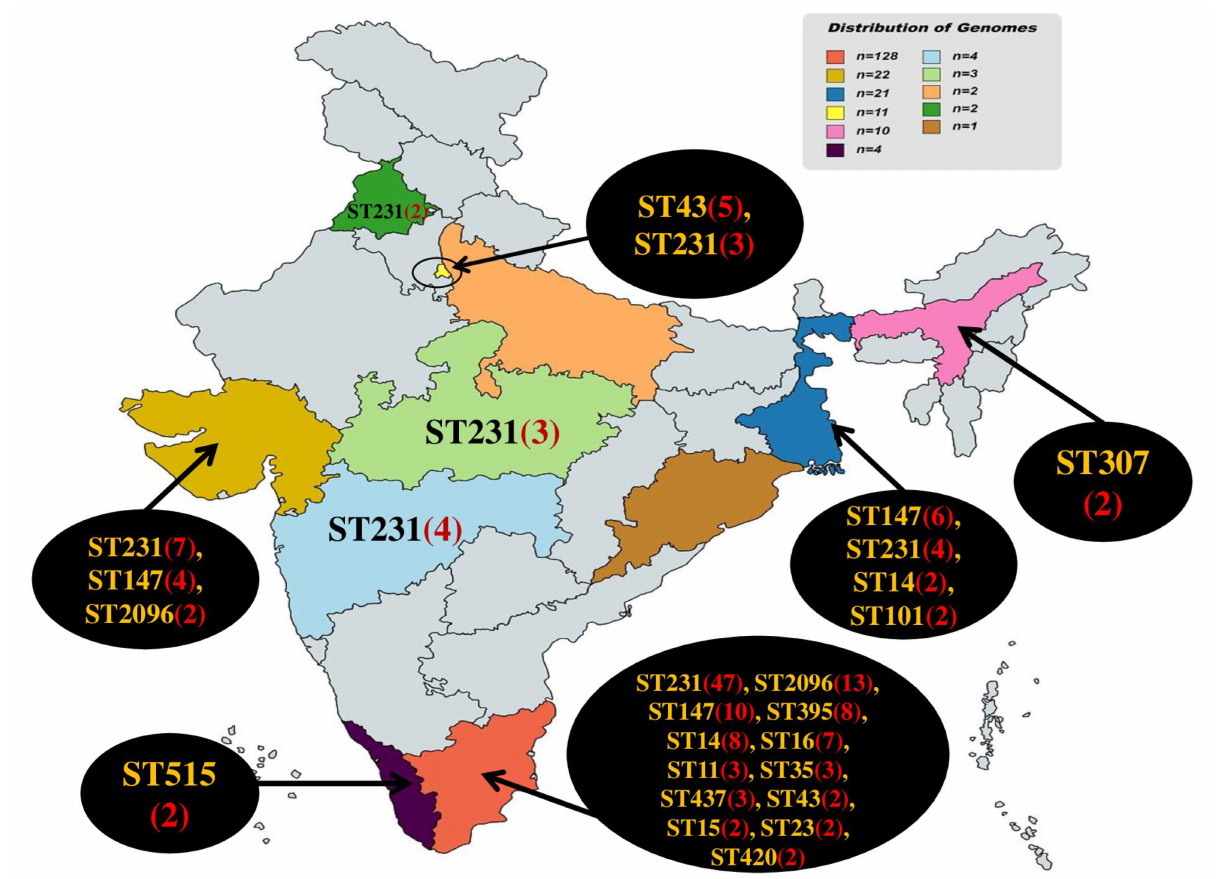
Figure 2. Geographic location of genome collection and state-wise ST distribution. ST found in at least 2 genomes are included in this figure. ( n ) Represents the number of genomes, and colors represent the states: carrot red ( n = 128)—Tamil Nadu; mustard yellow ( n = 22)—Gujarat; cyan ( n = 21)—West Bengal; yellow ( n = 11)—New Delhi; pink ( n = 10)—Assam; purple ( n = 4)—Kerala; sky blue ( n = 4)—Maharashtra; pastel green ( n = 3)—Madhya Pradesh; orange ( n = 2)—Uttar Pradesh; green ( n = 2)—Punjab; brown ( n = 1)—Orrisa. Digits in red fonts in brackets denote the number of genomes having respective STs. MapChart online tool was used to generate this